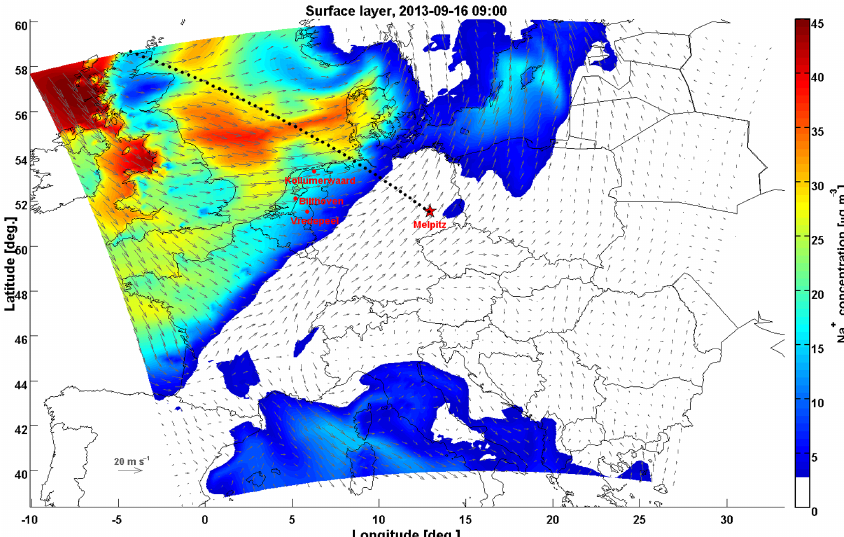
Figure 2. The horizontal distribution of surface Na + mass concentration in domain 02 (intermediate domain) at 16 September 2013, 09:00LT. The grey arrows indicate the wind field. The locations of four EMEP stations (Melpitz, Bilthoven, Kollumerwaard and Vredepeel) are marked. The vertical cross section of dash black line is shown in Fig.